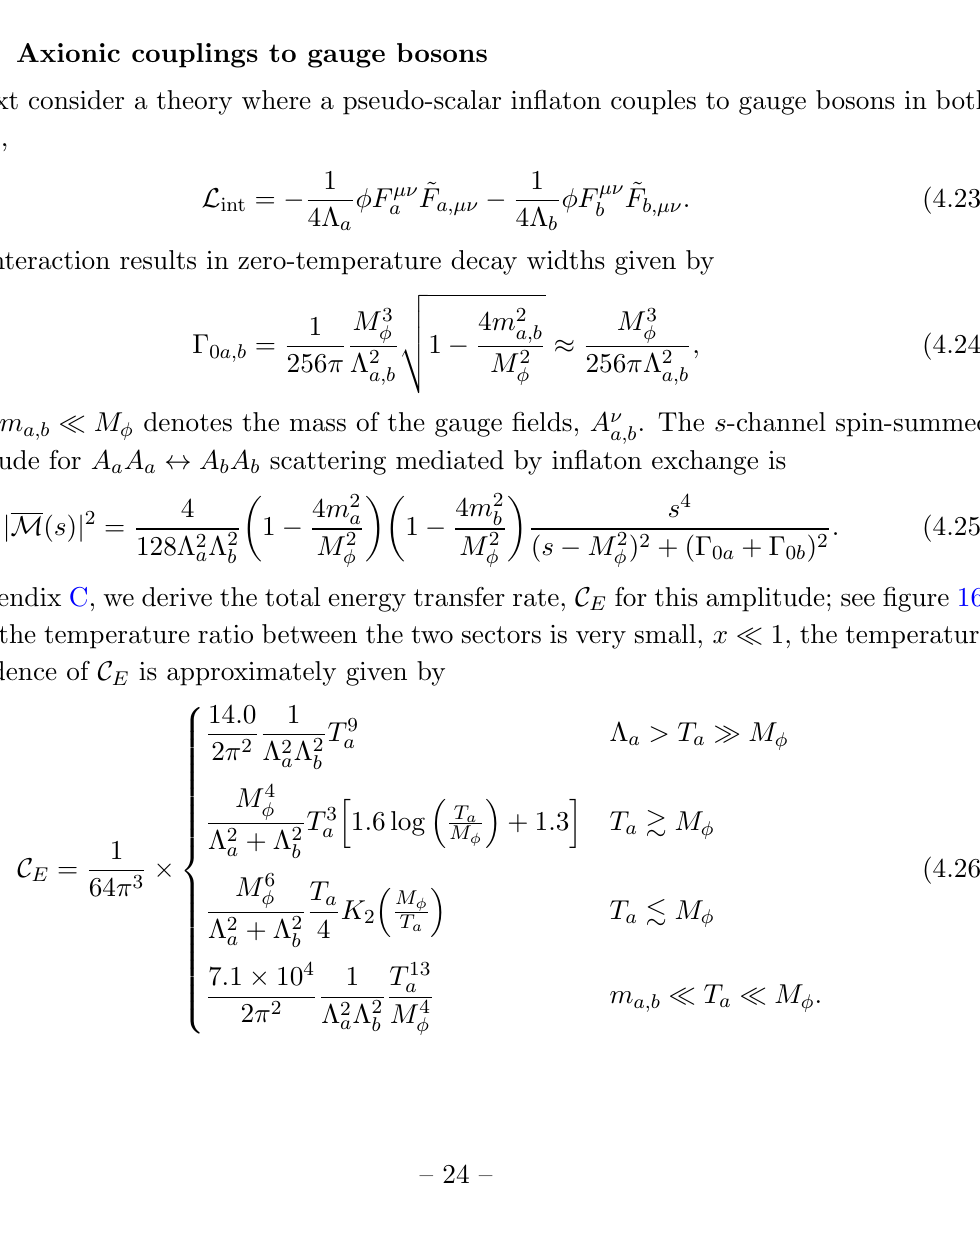
Figure 9. Left panel : contours of the (cid:12)nal temperature ratio obtained numerically, x f;n = T b =T a , shown in color, for an in(cid:13)aton with Yukawa couplings to fermions in both sectors. The white dashed lines show contours of log ( T rh =M (cid:30) ). Right panel : contours of relative fractional discrepancy, 10 j x f;a (cid:0) x f;n j =x f;n , where x f;a is the analytic estimate of eq. (4.16) with eq. (4.22), in percent. The white dashed contours depict x f;n and the red dashed line marks T rh = M (cid:30)